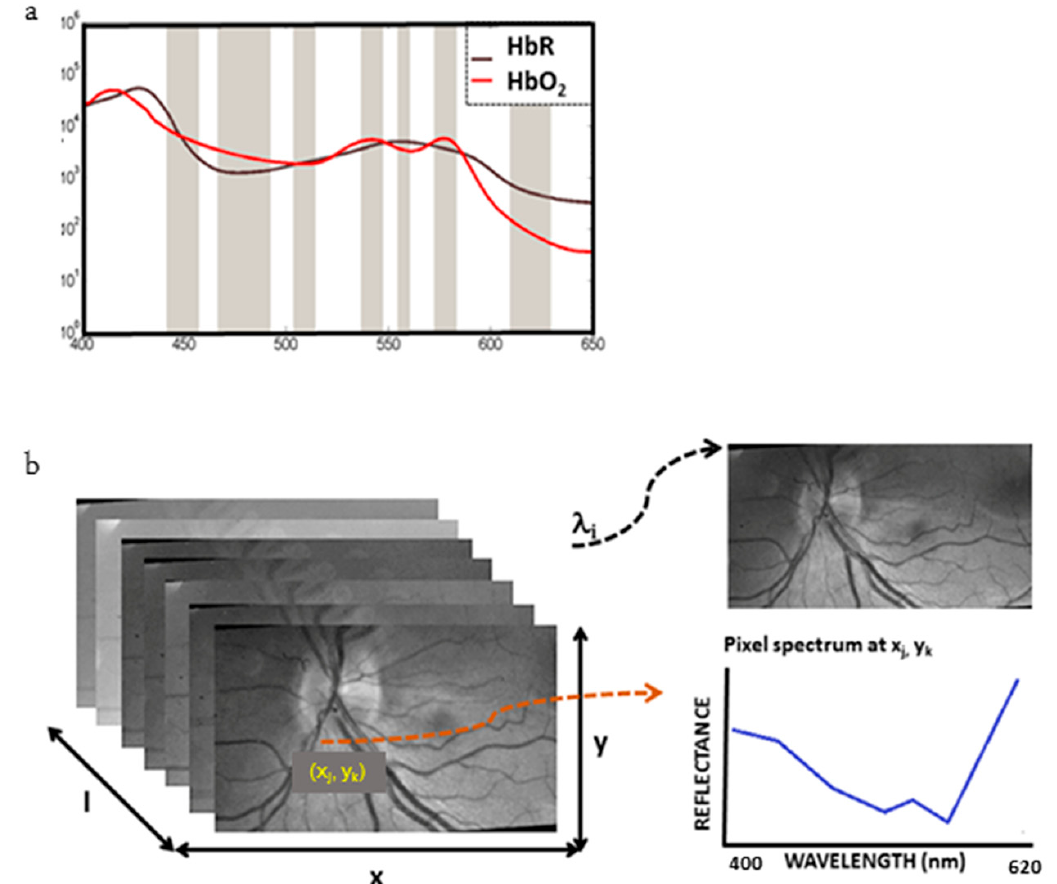
Figure 2. Illustration of the steps involved in retinal spectral imaging: ( a ) the measured optical spectroscopy spectrum of oxygenated haemoglobin (HbO 2 )0 or reduced haemoglobin (HbR) presented versus wavelength, ( b ) retinal multispectral dataset (or hypercube). An image plane is shown for one wavelength ( λ i) and a reflectance spectrum is obtained of one pixel (xj, yk).